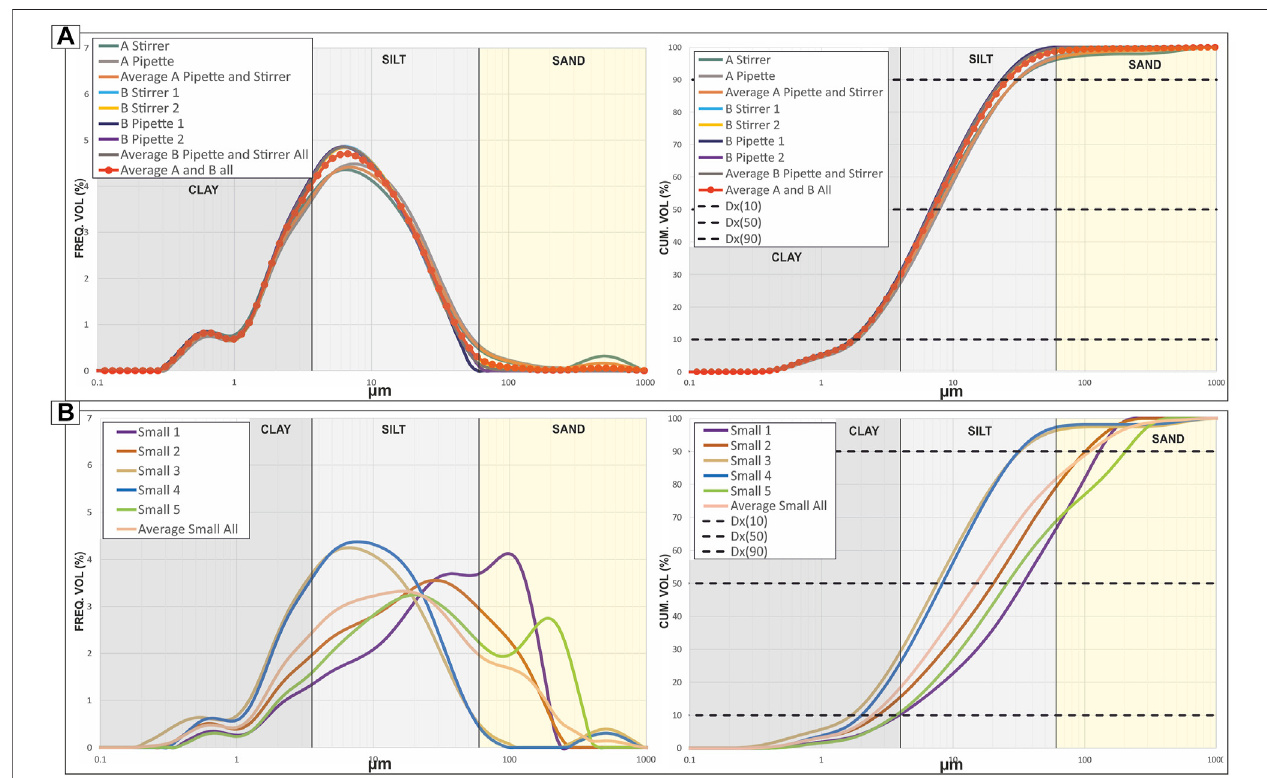
FIGURE 9 | Volume frequency and cumulative frequency graphs for fi eld sample C2 B0.4 S7. (A) Results from subsample A, pipette and stirrer, with average, and sub-sample B stirrer 1 and 2 as well as pipette 1 and 2, with average. An average for both sub-sample A and B combined is also shown. (B) Results for small sub- samples A, B, C, D, E, F, corresponding names small sample 1-5 and an average of all combined. For detailed results Supplementary Table S1 , for p -values Supplementary Table S2 .